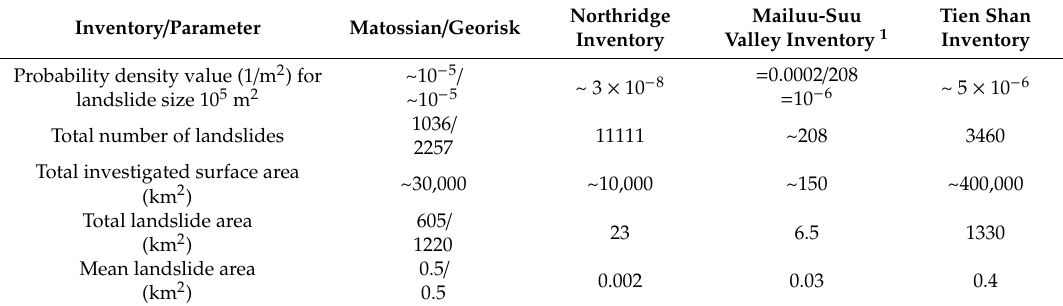
Table 1. Comparison of landslide distribution parameter values from several inventories: Matossian, Georisk, Northridge inventory (Malamud et al. [31]), Mailuu-Suu Valley inventory (Schlögel et al. [38]) and Tien Shan inventory (Havenith et al.